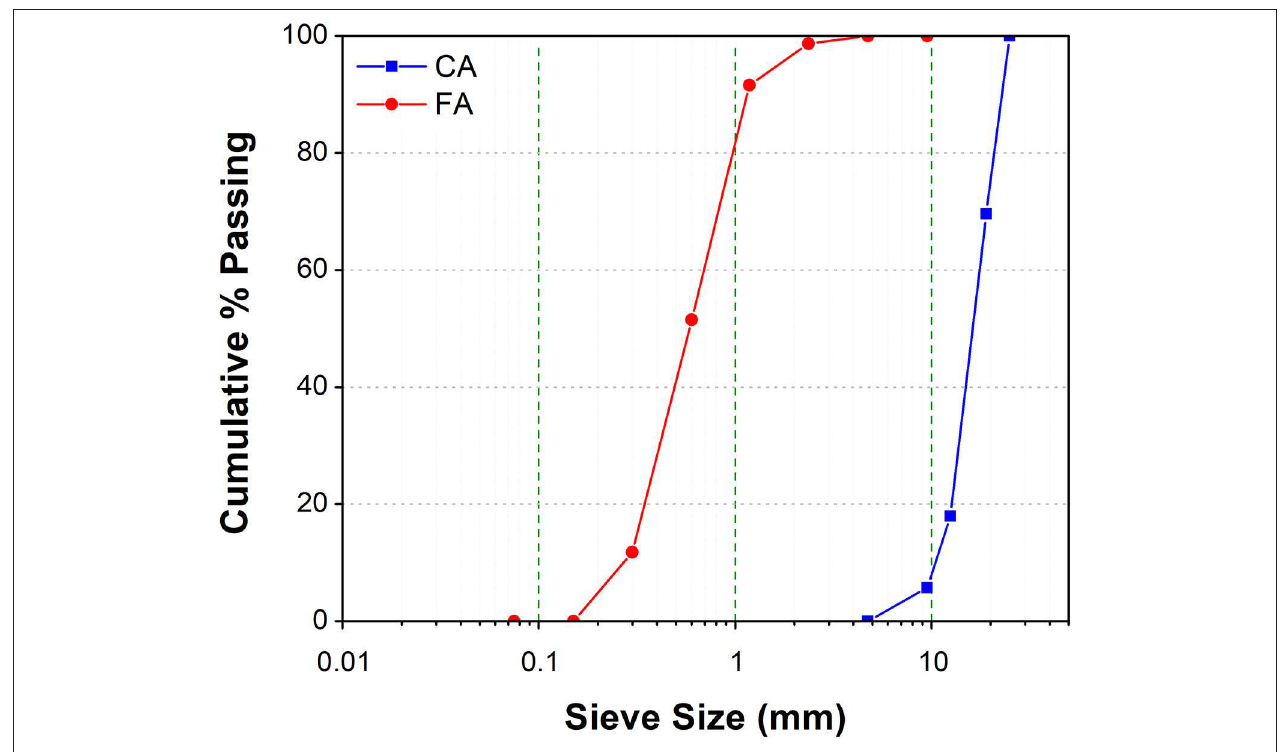
FIGURE 1 | Grain size distribution of coarse and fine